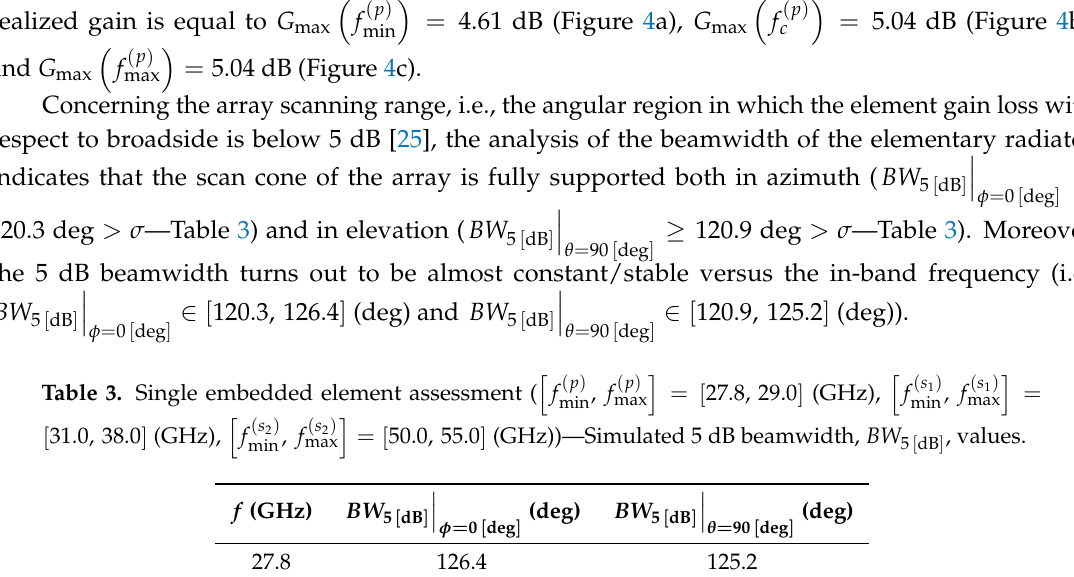
(cid:105) (cid:104) ( p ) ( p ) = [ 27.8, 29.0 ] (GHz))—3D plot of the f , f max min ( p ) ( p ) c ; and ( c ) f max .